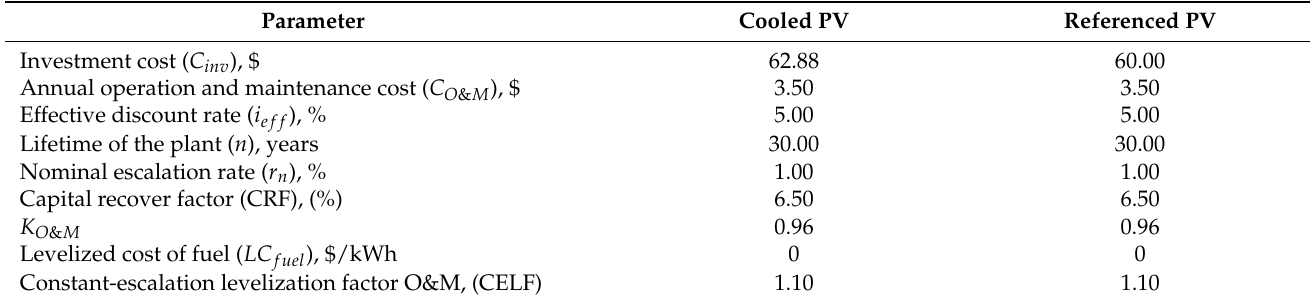
Table 3. Parameters used for the LCOE